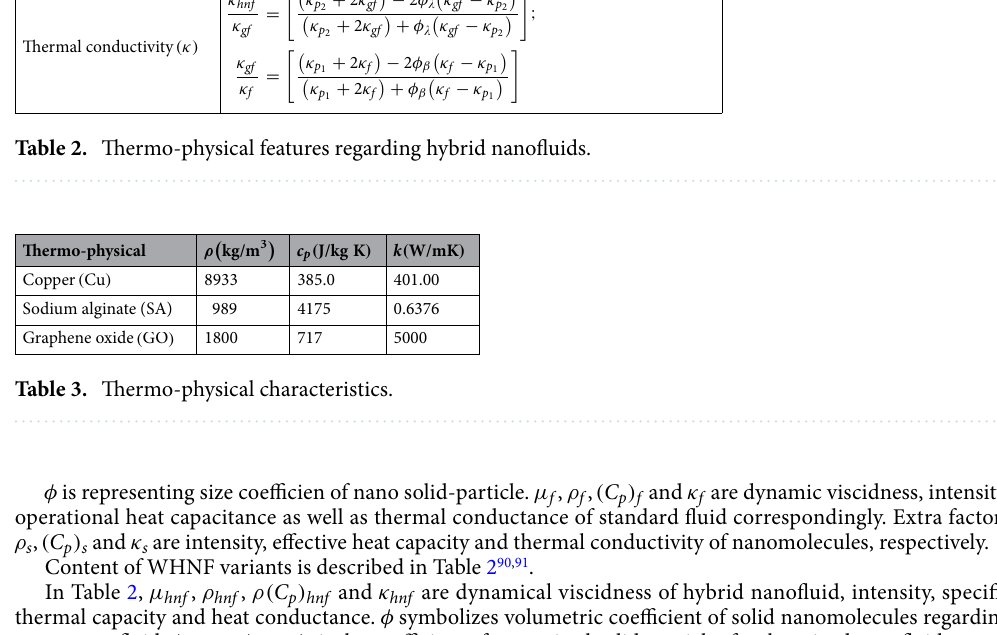
Content of WHNF variants is described in Table 2 90,91 . In Table 2, µ hnf , ρ hnf , ρ( C p ) hnf and κ hnf are dynamical viscidness of hybrid nanofluid, intensity, specific thermal capacity and heat conductance. φ symbolizes volumetric coefficient of solid nanomolecules regarding φ β φ (cid:31) is the coefficient of nano-sized solid-particles for the mixed nanofluid. µ f , ρ f , mono nanofluid. φ hnf = + ( C p ) f , κ f plus σ f are representing dynamic viscidness, density, specific heat capacitance and thermal conductance regarding basefluid. ρ p